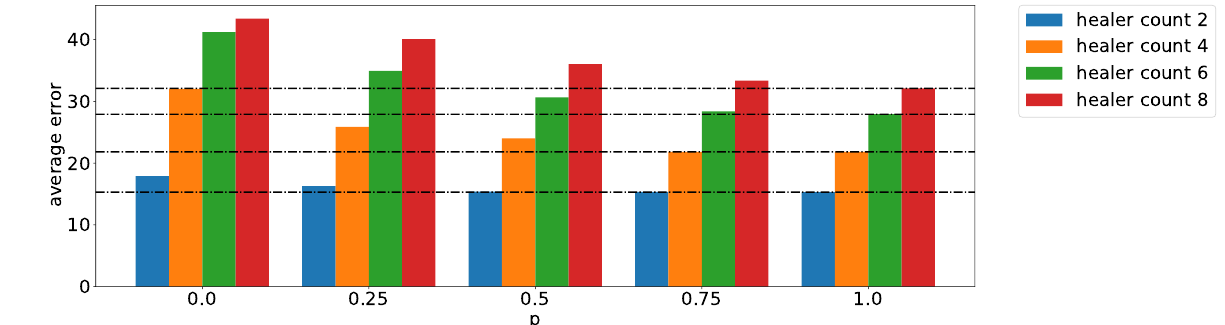
Figure 6. Average error (RMSE) for each combination of p and healer count. Horizontal lines mark the performance of p =